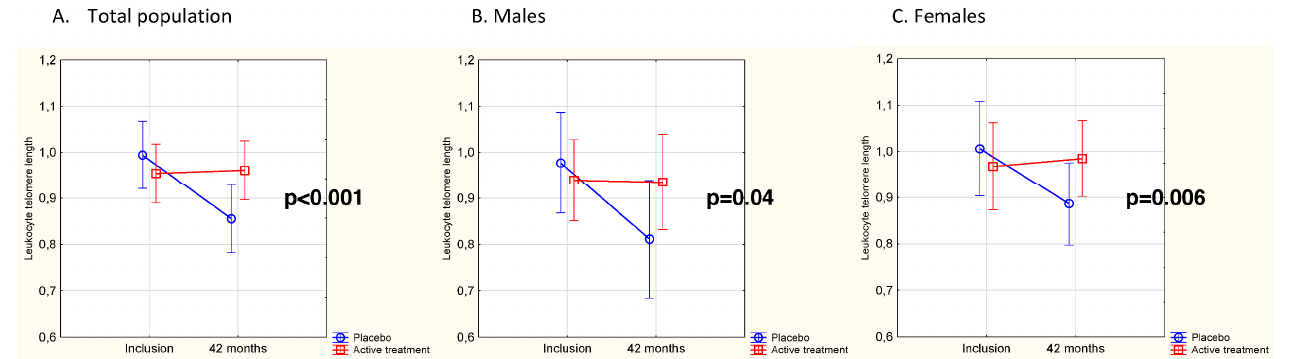
Figure 2. ( A ) LTL at baseline and after 42 months in the Se and coenzyme Q 10 treatment group compared to the placebo group in the total study population. Evaluation performed by use of repeated measures of variance. Current effect F(1,116) = 11.8, p < 0.001. Vertical bars denote 95% CI. The blue line represents the placebo group, the red line the active treatment group. ( B ) LTL in males at baseline and after 42 months in the Se and coenzyme Q 10 treatment group compared to the placebo group. Evaluation performed by use of repeated measures of variance. Current effect F(1, 51) = 4.63, p = 0.04. Vertical bars denote 95% CI. The blue line represents the placebo group, the red line the active treatment group. ( C ) LTL in females at baseline and after 42 months in the Se and coenzyme Q 10 treatment group compared to the placebo group. Evaluation performed by use of repeated measures of variance. Current effect F(1, 63) = 8.09, p = 0.006. Vertical bars denote 95% CI. The blue line represents the placebo group, the red line the active treatment